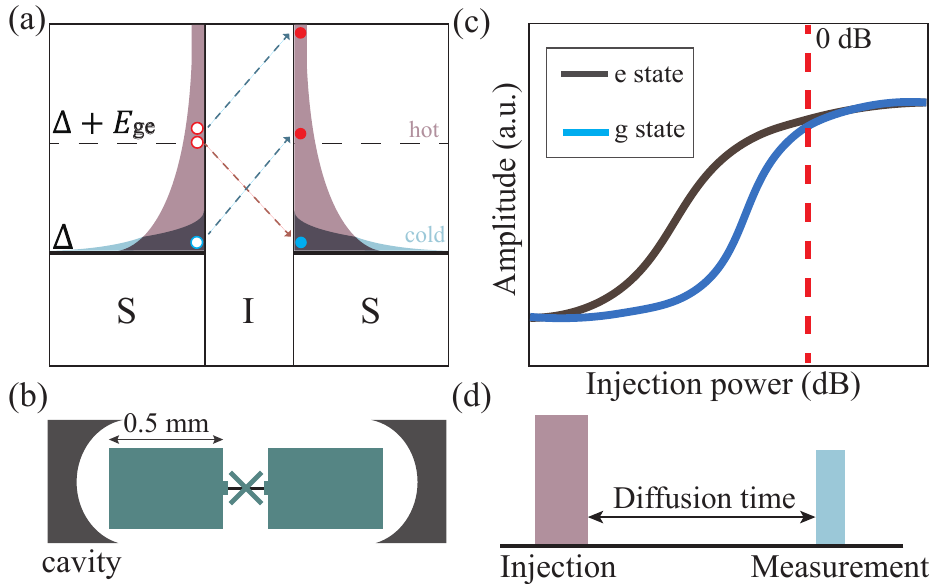
Figure 1. ( a ) Quasiparticle-induced transitions with quasiparticles’ energies near the superconducting gap ∆ and above ∆ + E ge . The blue dotted line indicates that the quasiparticles absorb energies, while the red one indicates that they emit energies. ( b ) Diagram of the Josephson junction centered between the two electrodes and placed in the 3D cavity. ( c ) Sketch of the response at ω bare versus the high input power. To inject quasiparticles, the injected microwave power needs to be above 0 dB, which is marked by the red line. ( d ) Pulse sequence of measurement for injecting